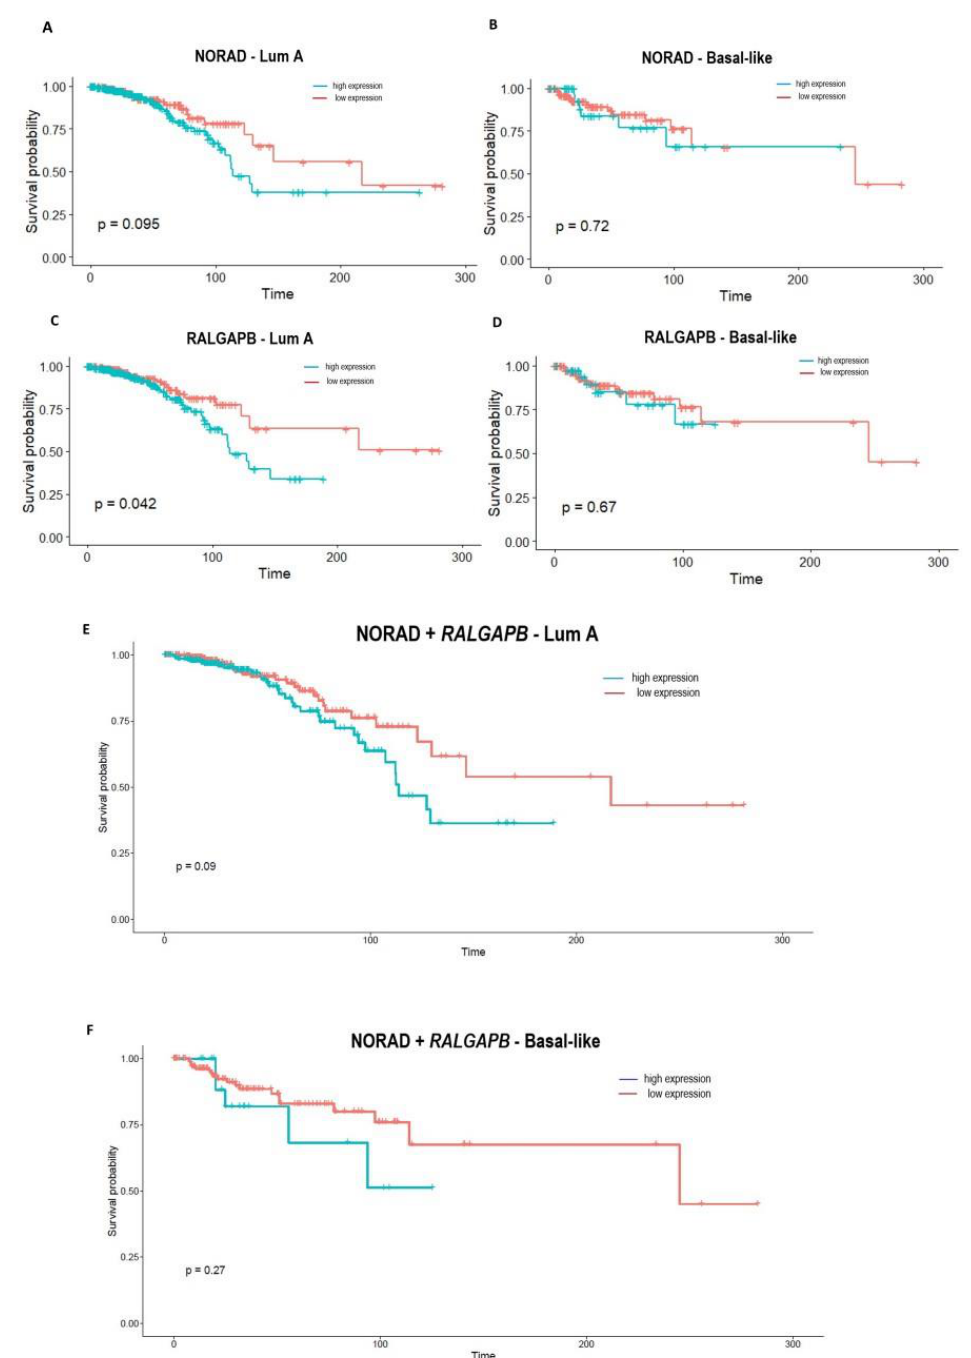
Figure 4. Overall survival analyses for Lum A and Basal-like patients related to lncRNA NORAD and RALGAPB expression. Legend: ( A ) Survival analysis considering the median value of NORAD in Lum A (High expression ( n = 304), Low expression ( n = 185)) and ( B ) Basal-like patients (High expression ( n = 37), Low expression ( n = 131)). ( C ) Survival analysis considering the median value of RALGAPB in Lum A (High expression ( n = 282), Low expression ( n = 207)), and ( D ) Basal-like patients (High expression ( n = 38), Low expression ( n = 130)). ( E ) Survival combined panel analysis with NORAD and RALGAPB in Lum A patients. ( F ) Survival combined panel analysis with NORAD and RALGAPB in Basal-like patients. Red and blue lines refer to patients with low and high expression, respectively. A p -value < 0.05 was considered